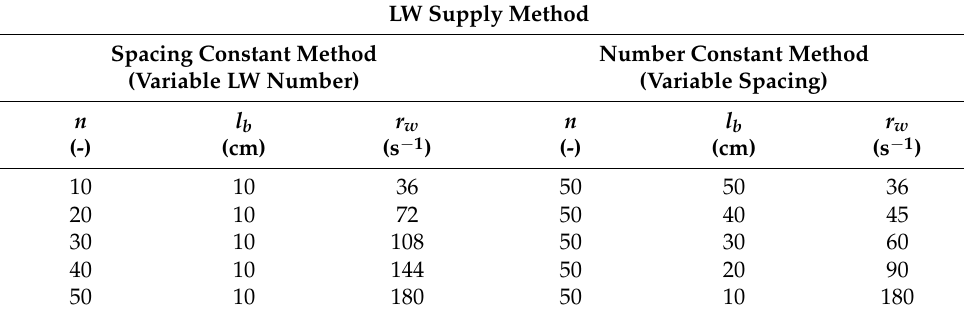
Table 2. Experimental